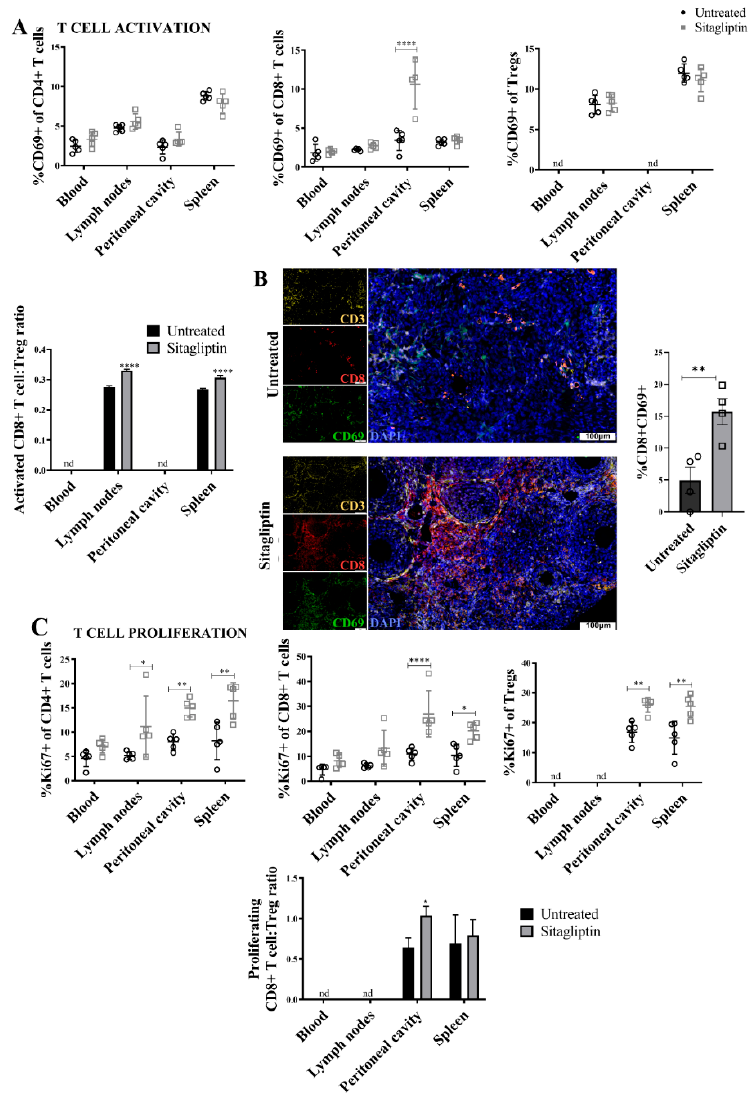
Figure 4. Lymphocyte activation and proliferation in ID8 tumour-bearing mice treated with sitagliptin. Leukocytes were isolated from the blood, lymph nodes, peritoneal cavity and spleen of ID8 pROSA -iRFP720-bearing mice at week four post-inoculation and examined using a BD LSRFortessa X-20 (BD Biosciences). ( A ) Percentage of activated (CD69+) CD4+ T cells, CD8+ T cells, and T regulatory cells of the corresponding parent population, and ratio of CD69+ CD8+ T cells to CD69+ Tregs in each of the compartments examined. ( B ) Representative images of ovarian tumour sections stained with CD3 (yellow), CD8 (red) and CD69 (green) at week four post tumour inoculation. Nuclei were stained with DAPI (blue). Bar graph shows the percentage area of ovarian tumour sections stained with CD8+CD69+. Images were acquired using the VS120 Virtual Slide Microscope (Olympus Corporation, Japan) and processed using the Olyvia software v2.9.1 (Olympus Corporation, Japan). Data were analysed by calculating the percentage area of CD8+CD69+ colocalisation of total tissue area using a consistent binary threshold in ImageJ v1.0 (National Institute of Health, MD, USA). ( C ) Percentage of proliferating (Ki67+) CD4+ T cells, CD8+ T cells, and T regulatory cells of the corresponding parent population, and ratio of Ki67+ CD8+ T cells to Ki67+ Tregs in each of the compartments examined. Flow cytometry data are presented as mean ± SD, n = 5. * = p < 0.05; ** = p < 0.01; **** = p <